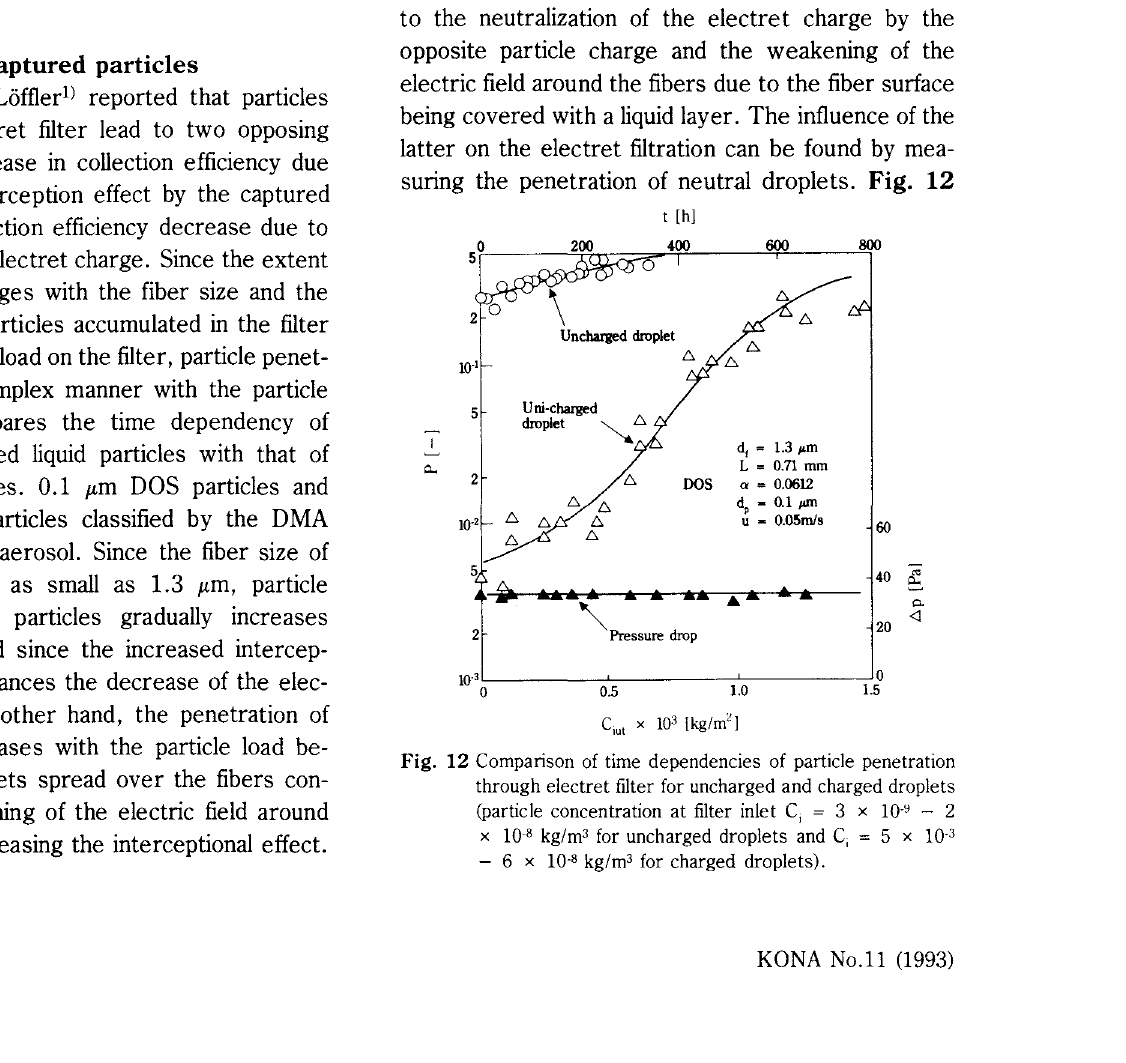
Fig. 12 Comparison of time dependencies of particle penetration through electret filter for uncharged and charged droplets (particle concentration at filter inlet C, = 3 x 10·" - 2 x 10·8 kg/m3 for uncharged droplets and C, = 5 x 10-3 - 6 x 10·8 kgfm3 for charged